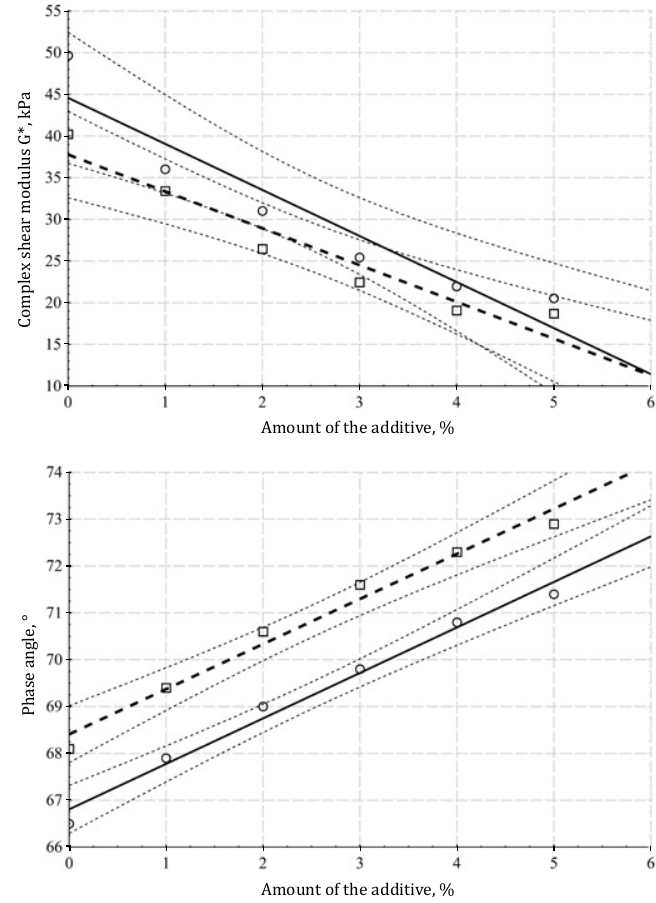
Figure 10. Complex shear modulus and phase angle obtained in Dynamic Shear